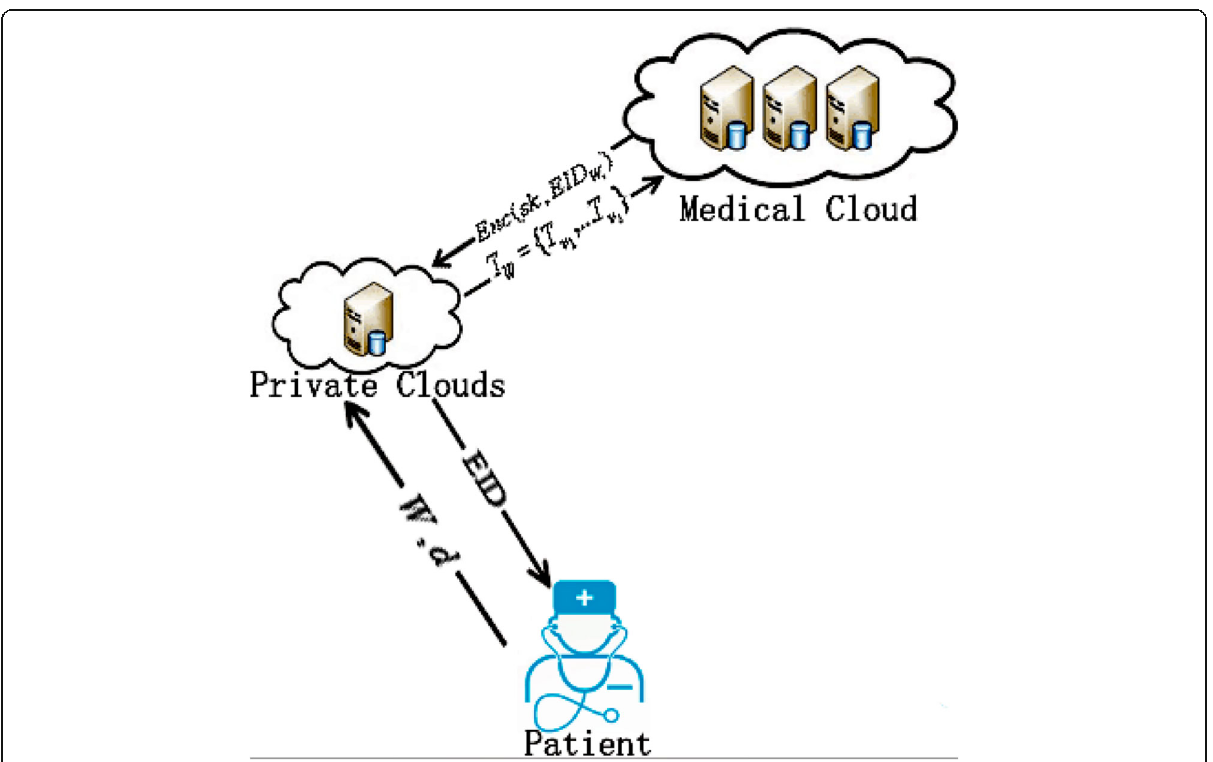
Fig. 4 The keyword fuzzy search of medical personnel